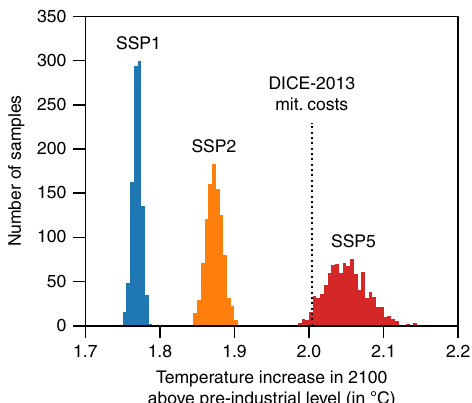
Fig. 7 Economically optimal temperature increase for alternative mitigation-cost functions. The mitigation functions, which are sampled from the SSP fi t, re fl ect different technological possibilities in the future as re fl ected by the SSPs. The dotted line shows the value for the benchmark estimate